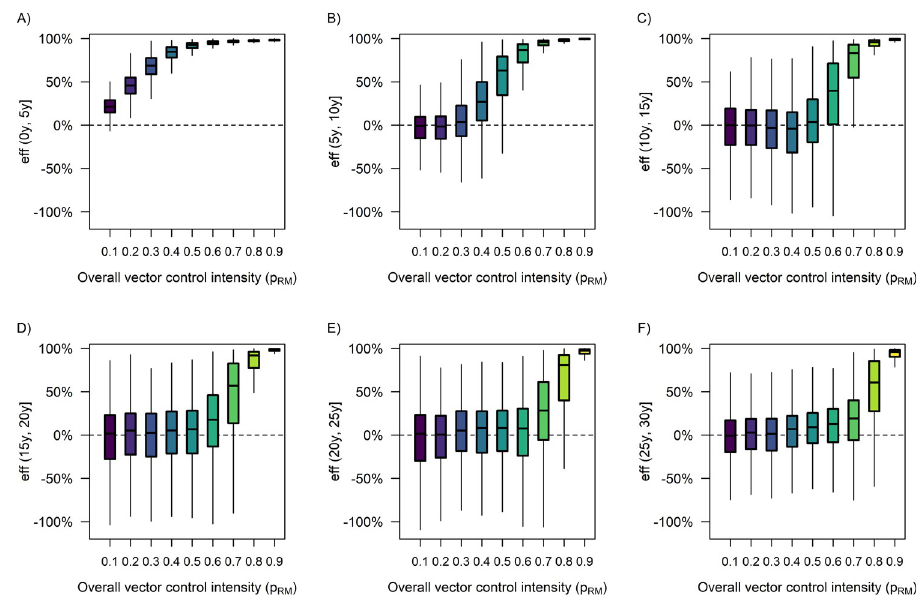
Fig 6. Distribution of the simulated intervention effectiveness under different overall levels of vector control intensity within each of the following time windows : (A) (0y, 5y], (B) (5y, 10y], (C) (10y, 15y], (D) (15y, 20y], (E) (20y, 25y], (F) (25y, 30y]. Each box was drawn from the first quartile (Q1) to the third quartile (Q3) of the data, with the horizontal line in the middle showing the median. The upper whisker boundary was the largest observation that was within Q3 + 1.5 � (Q3—Q1), and the lower whisker boundary was the smallest observation above Q1–1.5 � (Q3— Q1). Data points beyond the whisker boundaries were omitted from the graph for clarity.